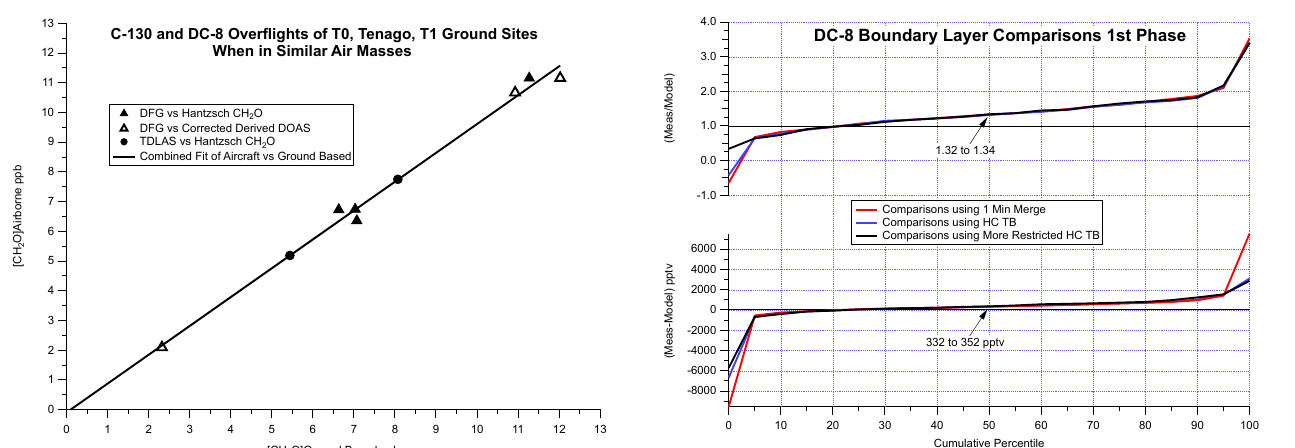
Fig. 2. The airborne DC-8 and C-130 CH 2 O spectroscopic